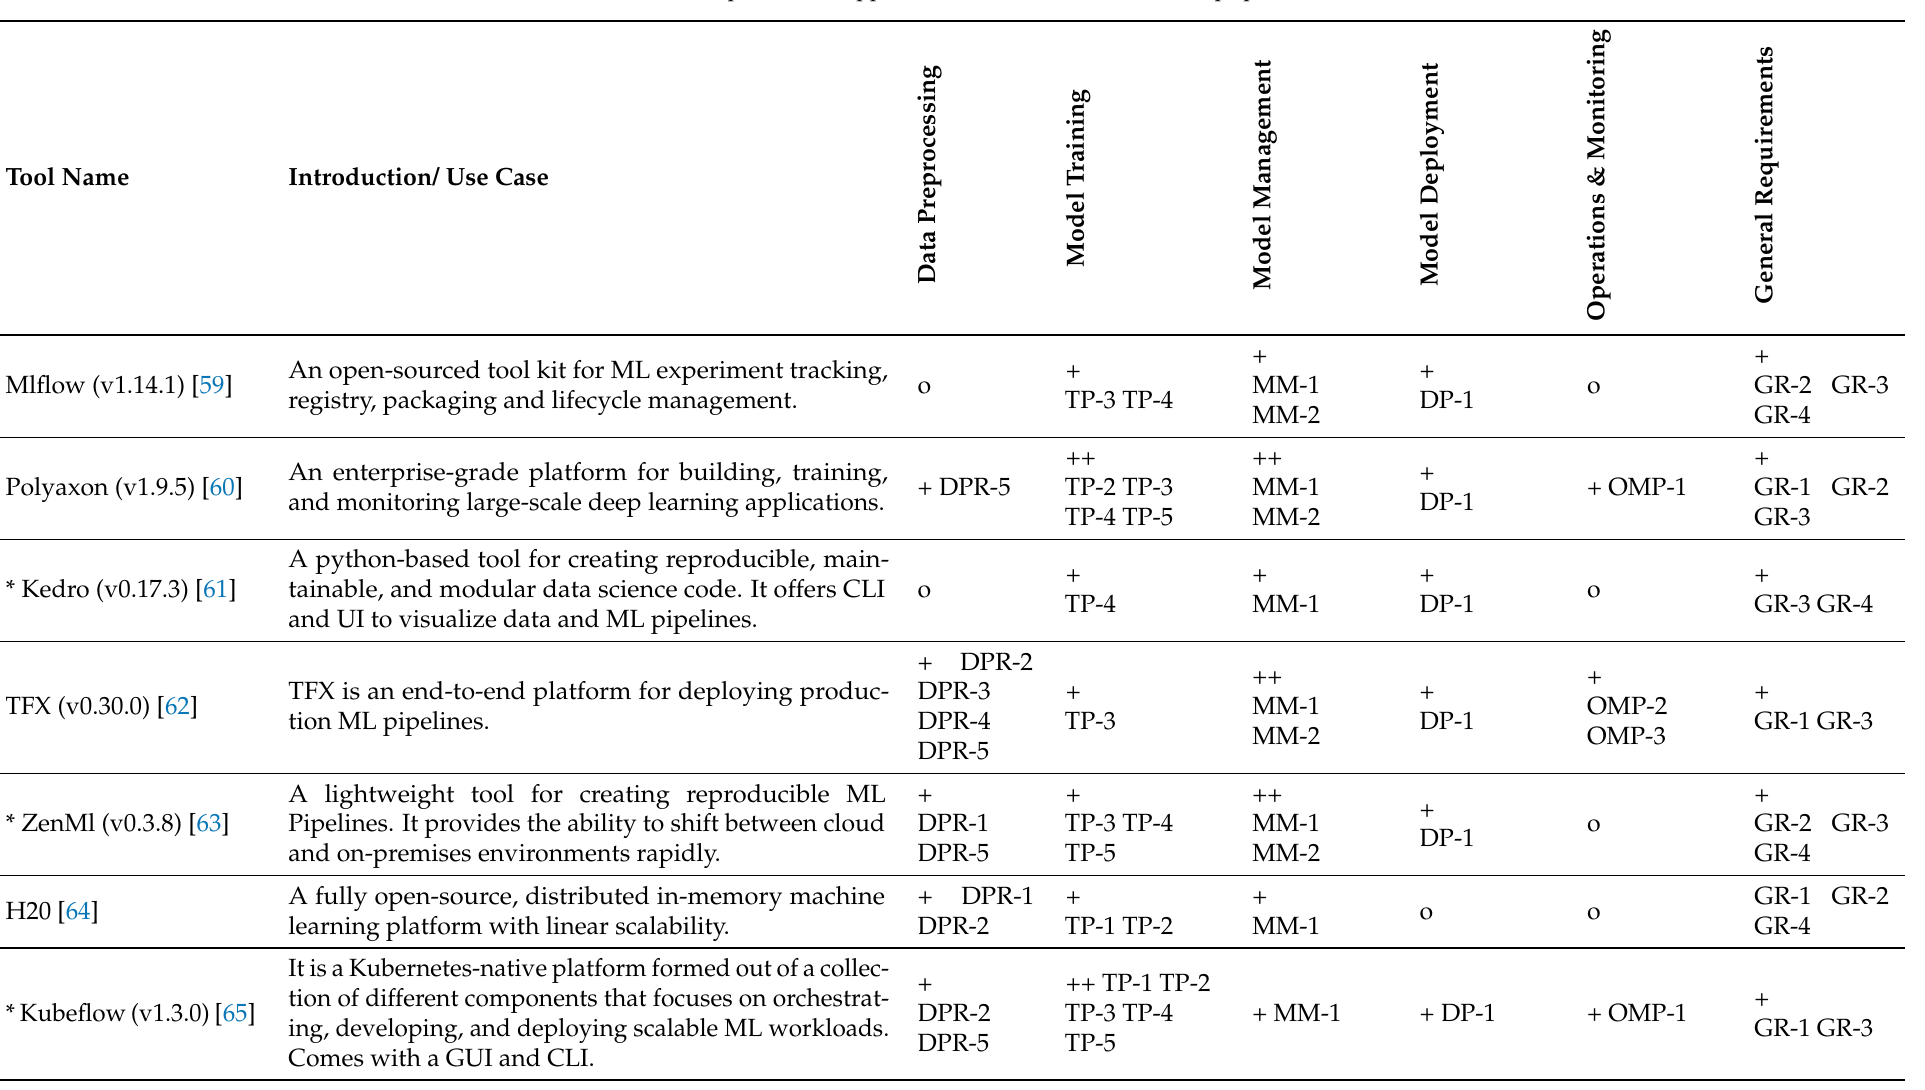
Table 5. A comparison of supportive tools for the different MLOps